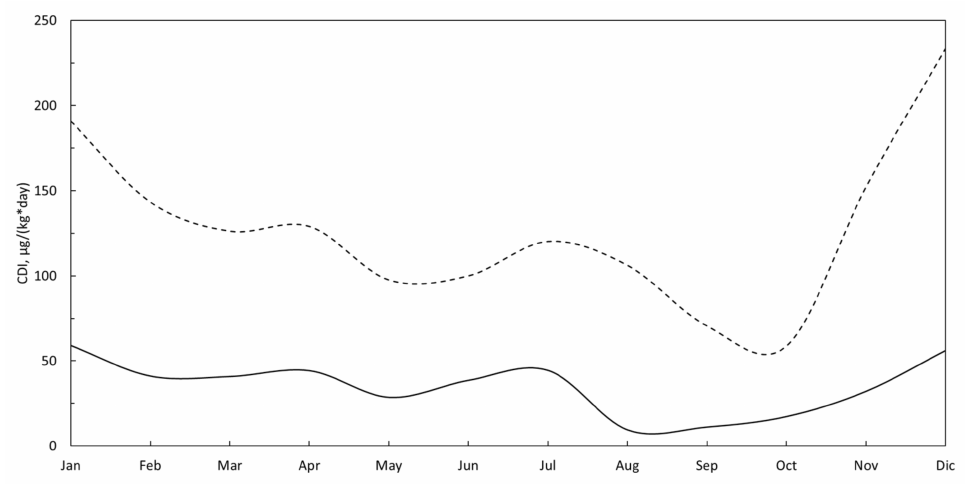
Figure 9. PM10 CDI for the HI (solid black line) and LI (dashed black line) area for every month in 2016.